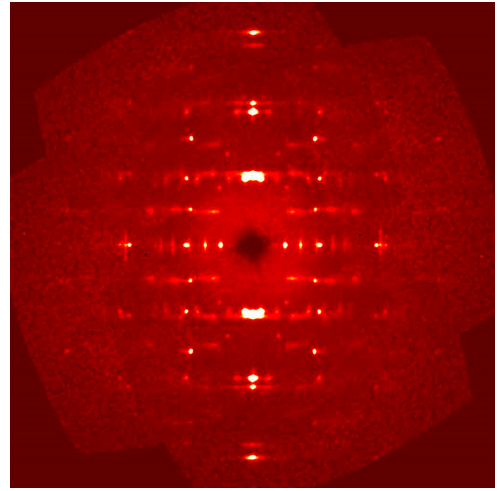
Figure 10. Reconstructed precession image of the [001] zone of a single merelaniite whisker (sample 3665LB) obtained with single-crystal X-ray diffraction. Table 3. X-ray diffraction data (using Cu K α ) belonging to the Q -subcell of merelaniite. The two most intense reflections are indicated in boldface type.